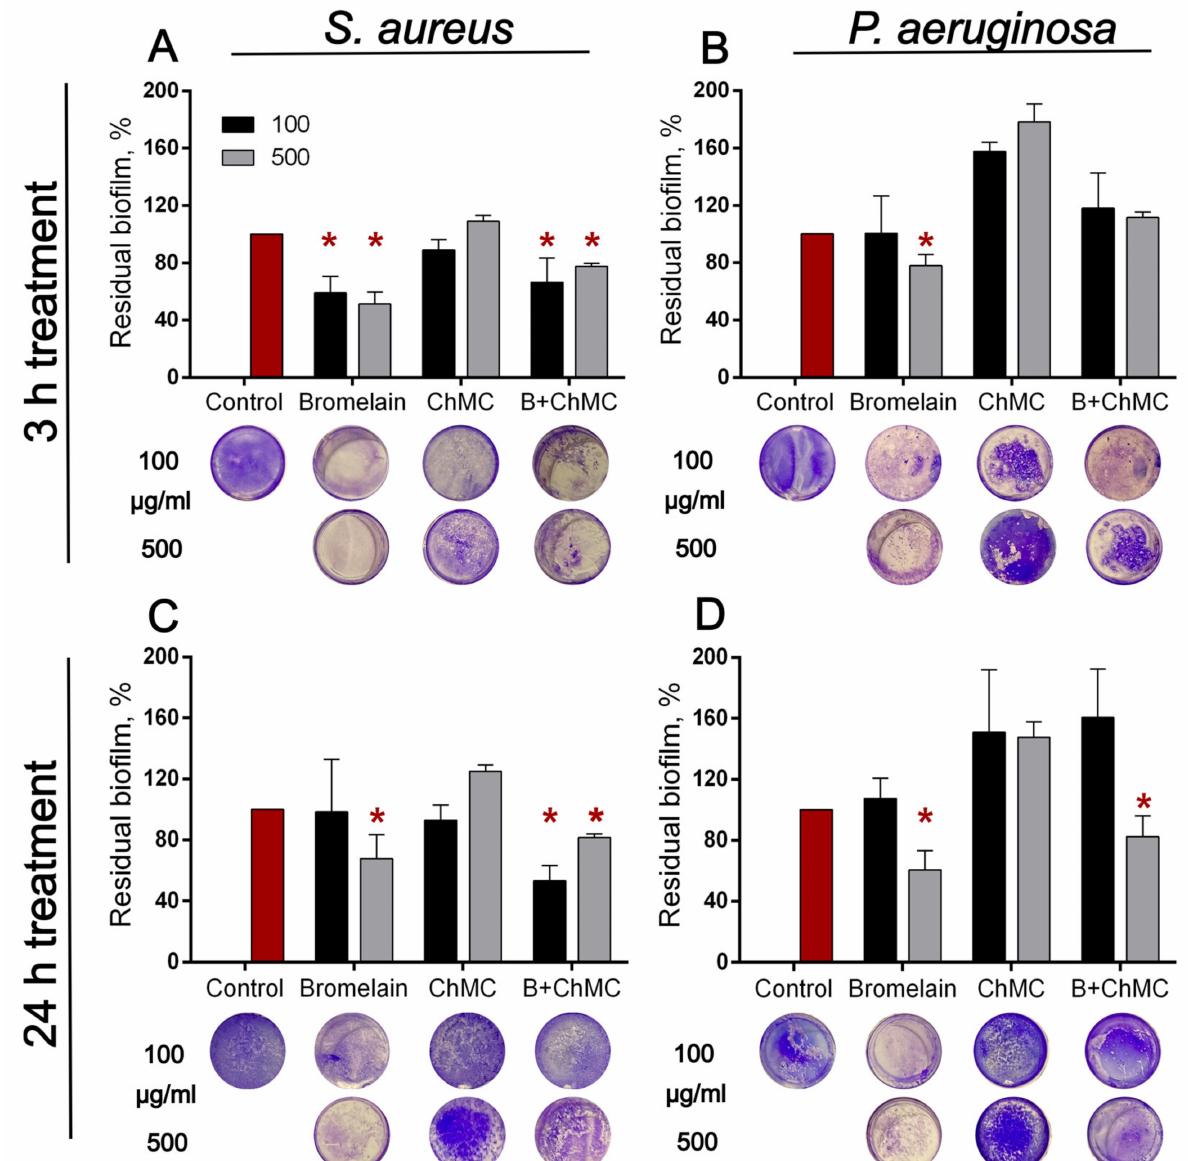
Figure 7. Effect of dissolved bromelain and enzyme immobilized on carboxymethylchitosan (ChMC) on ( A , C ) S. aureus and ( B , D ) P. aeruginosa biofilms. The 48 h old biofilms were gently washed and treated for 3 ( A , B ) or 24 h ( C , D ) with enzymes at concentrations of 0.1 and 0.5 mg · mL − 1 . The amount of heterogeneous enzyme corresponded to 0.1 and 0.5 mg · mL − 1 of the soluble enzyme, and as a negative control, pure carriers were taken in similar concentrations. Residual biofilms were quantified with crystal violet staining. Asterisks (*) denote statistically significant differences between untreated and treated samples ( p < 0.05). Untreated wells were considered to be